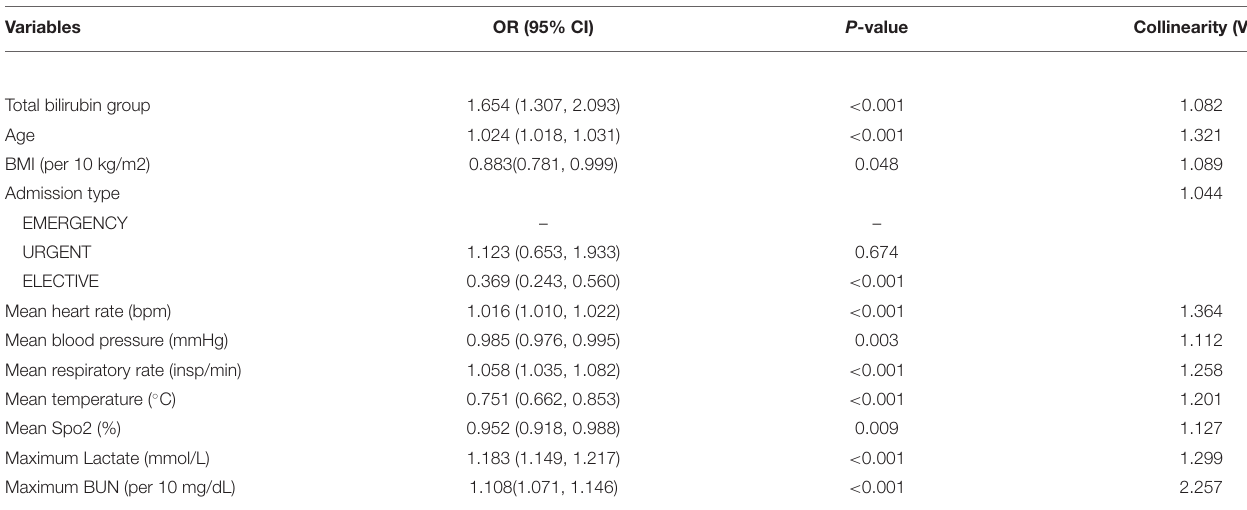
TABLE 3 | Predictors of mortality in critically ill patients.